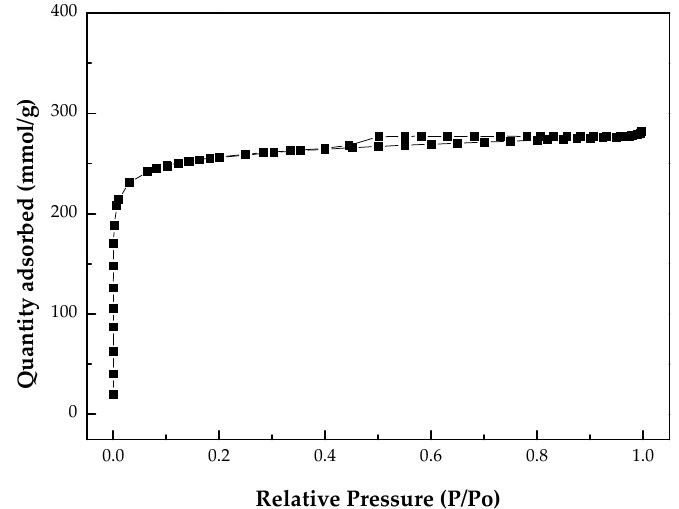
Figure 1. N 2 adsorption–desorption isotherms of resulting activated carbon (WCH-AC).